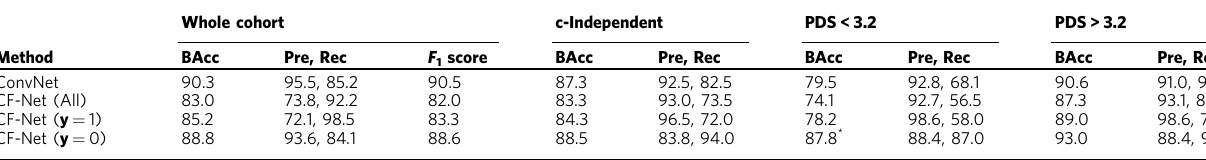
Table 2 BAcc (precision and recall) on predicting sex from MRIs of NCANDA matched with respect to PDS. Optimal results were achieved when conditioning CF-Net on boys.